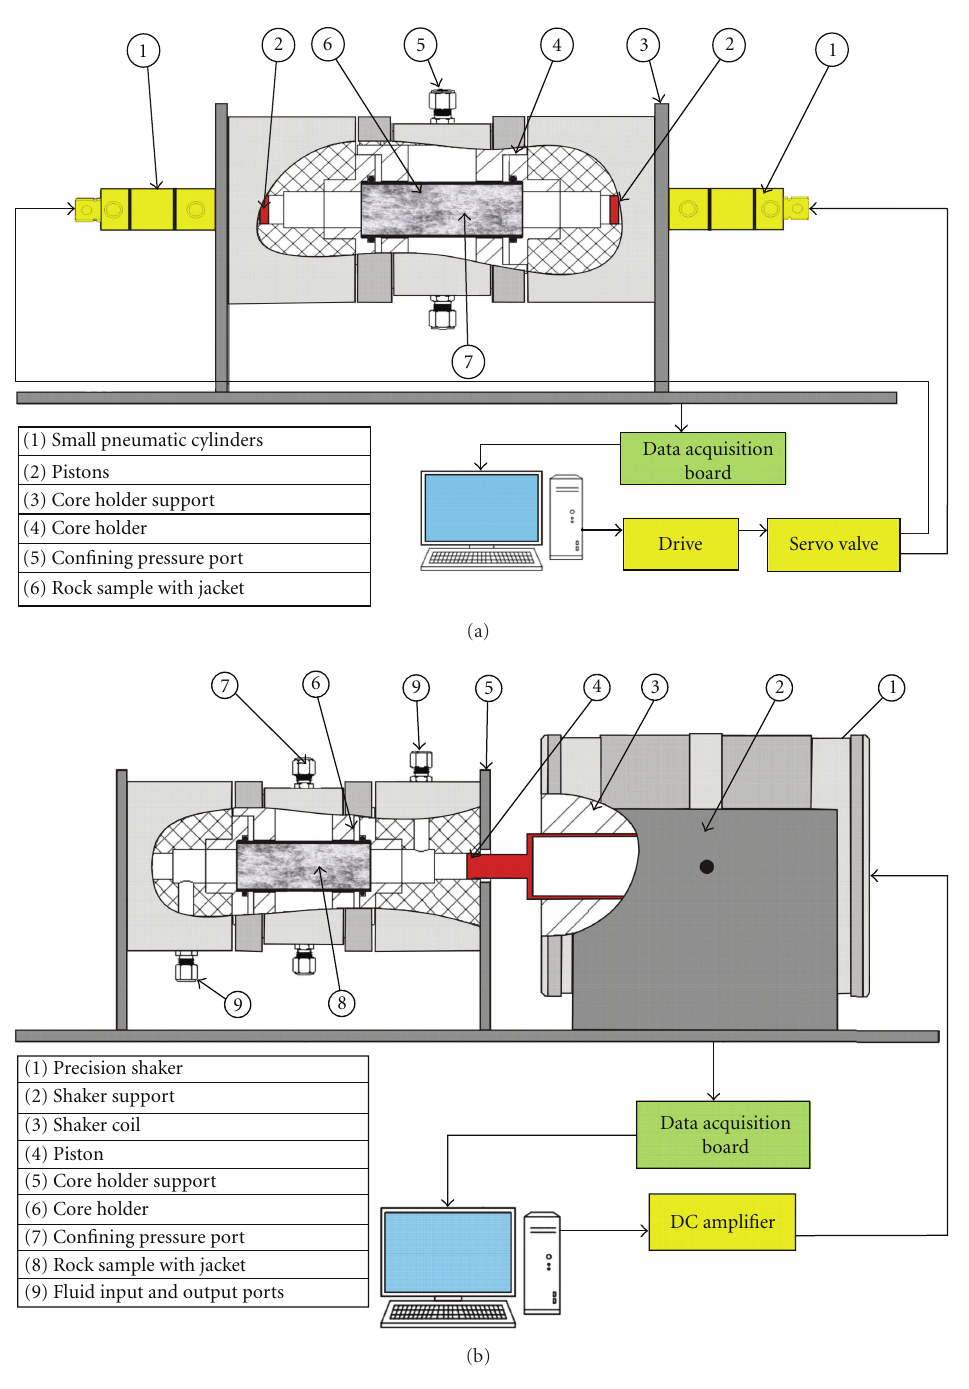
Figure 3: Conceptual AC electrokinetic cells with (a) pneumatic and (b) electromagnetic